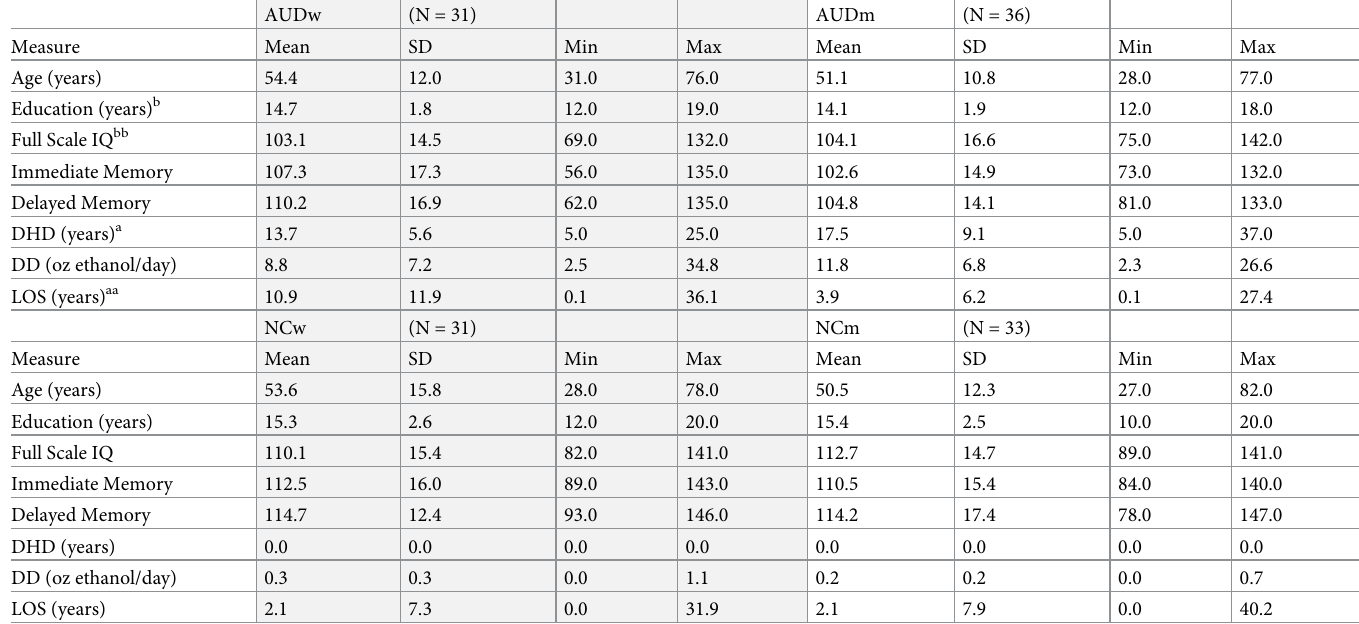
Table 1. Participant